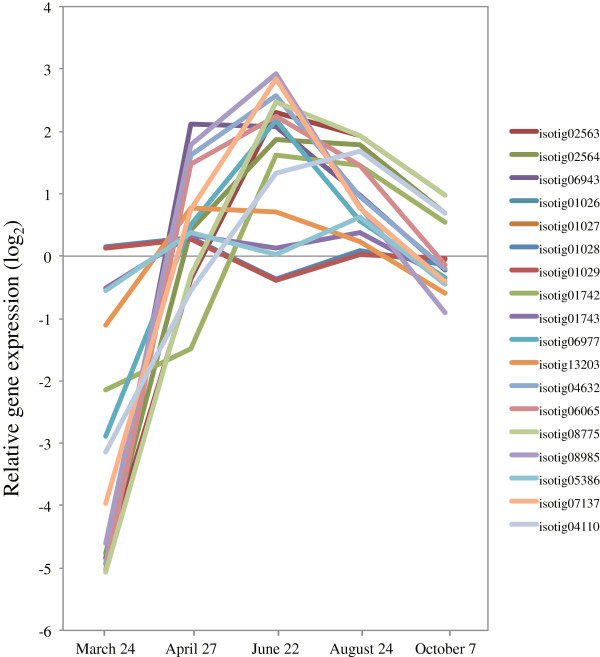
Expression of laccase genes in cambial region during xylem formation. The individual targets are summarized in Additional file 3. All expression data are presented on a log2 scale.